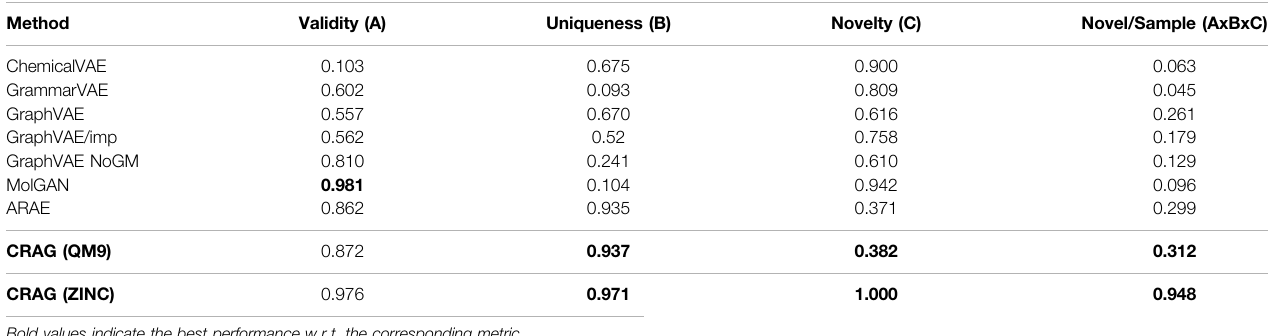
Bold values indicate the best performance w.r.t. the corresponding metric.